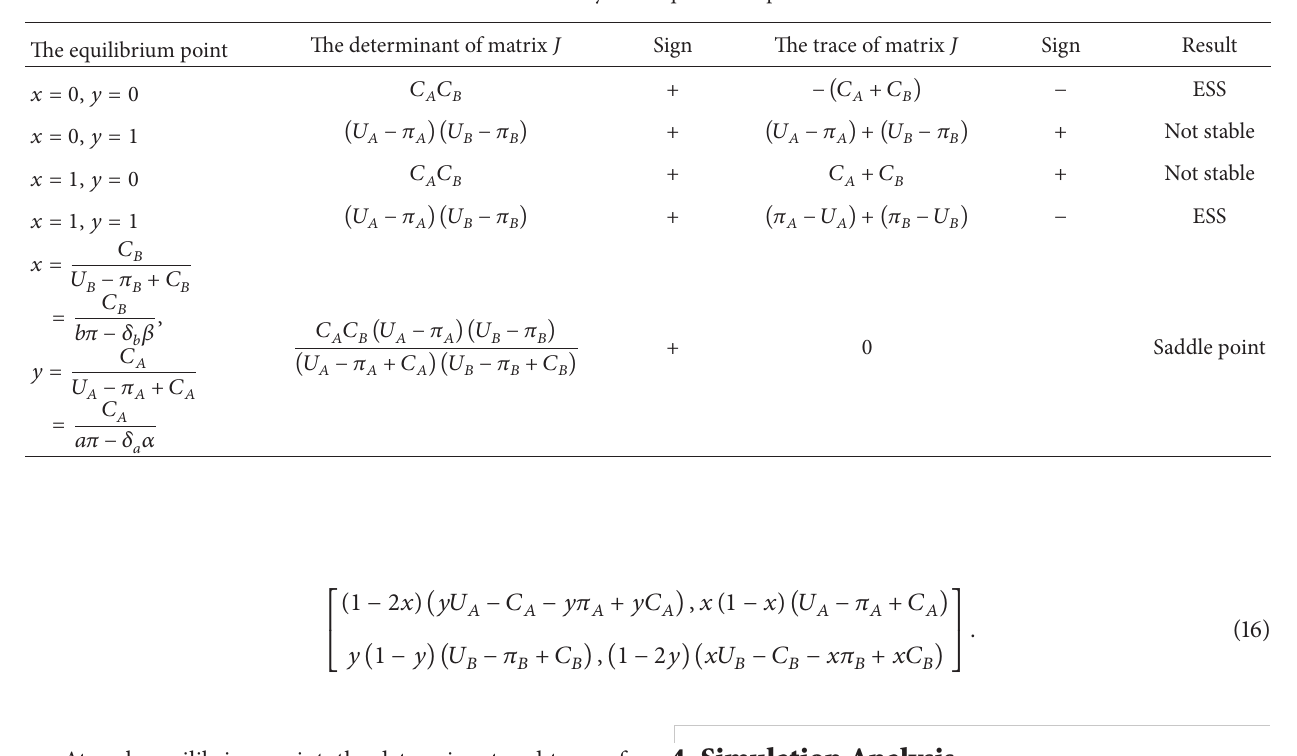
Table 2: Analysis of equilibrium